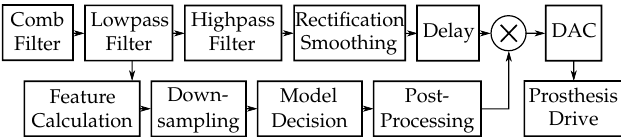
Figure 1. First, the EMG signal coupled from the human body is amplified and filtered by the analog circuit (ASP). In the µ C, the signal is then digitally filtered and evaluated (DSP). The contraction EMG signal is provided at the prosthesis drive via the digital-to-analog converter (DAC). For experimental applications, the signal can be connected to the oscilloscope or Bluetooth (BLE) module (Adapted from Roland et al. [2]).